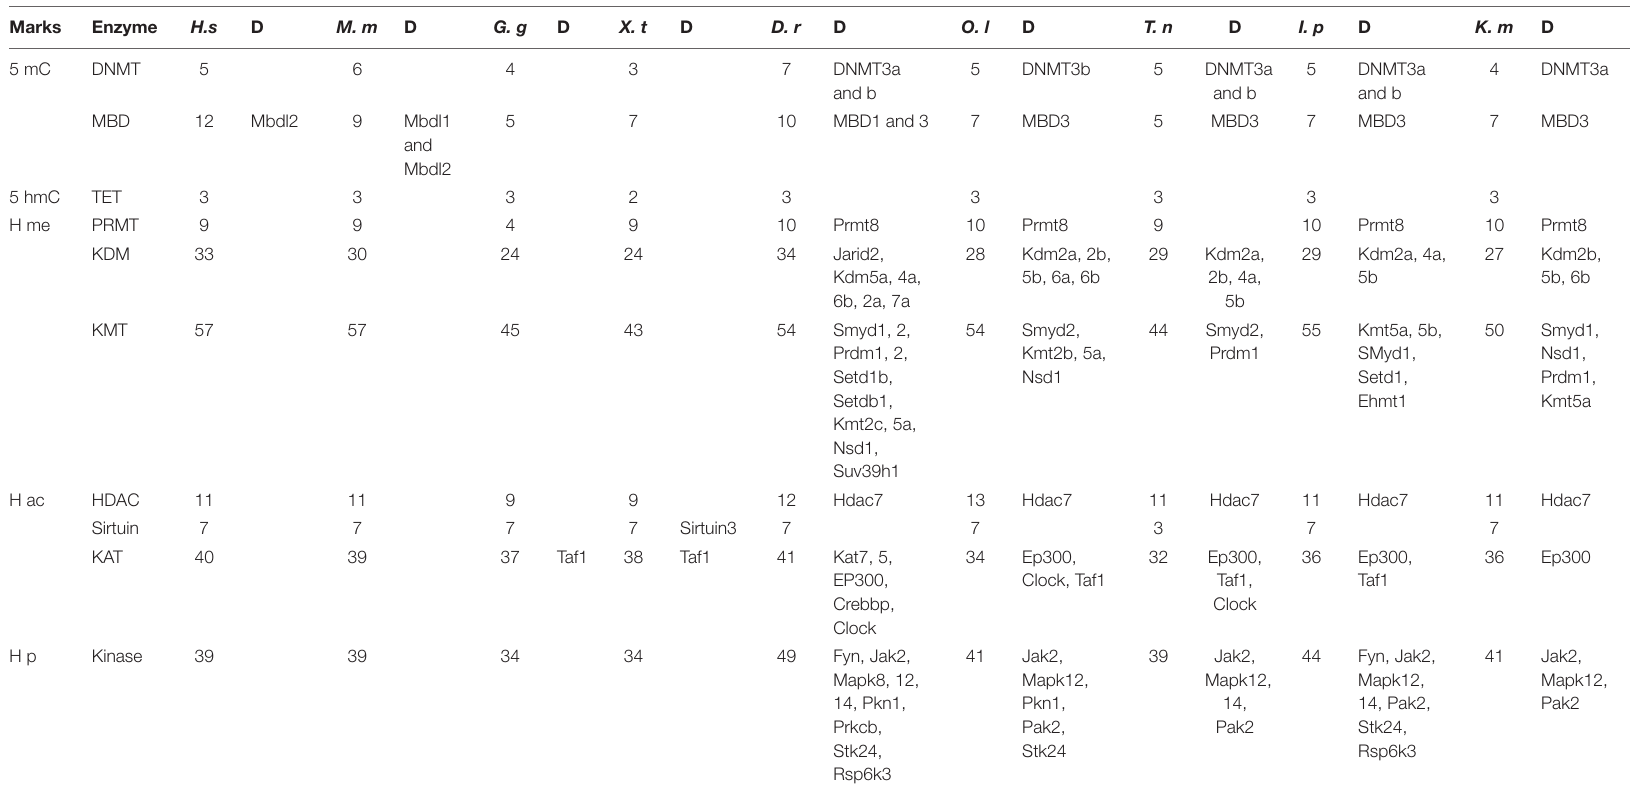
TABLE 2 | Epigenetic toolkit of human ( Homo sapiens , H. s ), mouse ( Mus musculus , M. m ), chicken ( Gallus gallus , G. g ), tropical clawed frog ( Xenopus tropicalis , X. p ), zebrafish ( Danio rerio , D. r ), medaka ( Oryzias latipes , O. l ), green spotted puffer ( Tetraodon nigroviridis , T, n ), channel catfish ( Ictalurus punctatus , I. p ), and mangrove rivulus ( Kryptolebias marmoratus , K. m ).